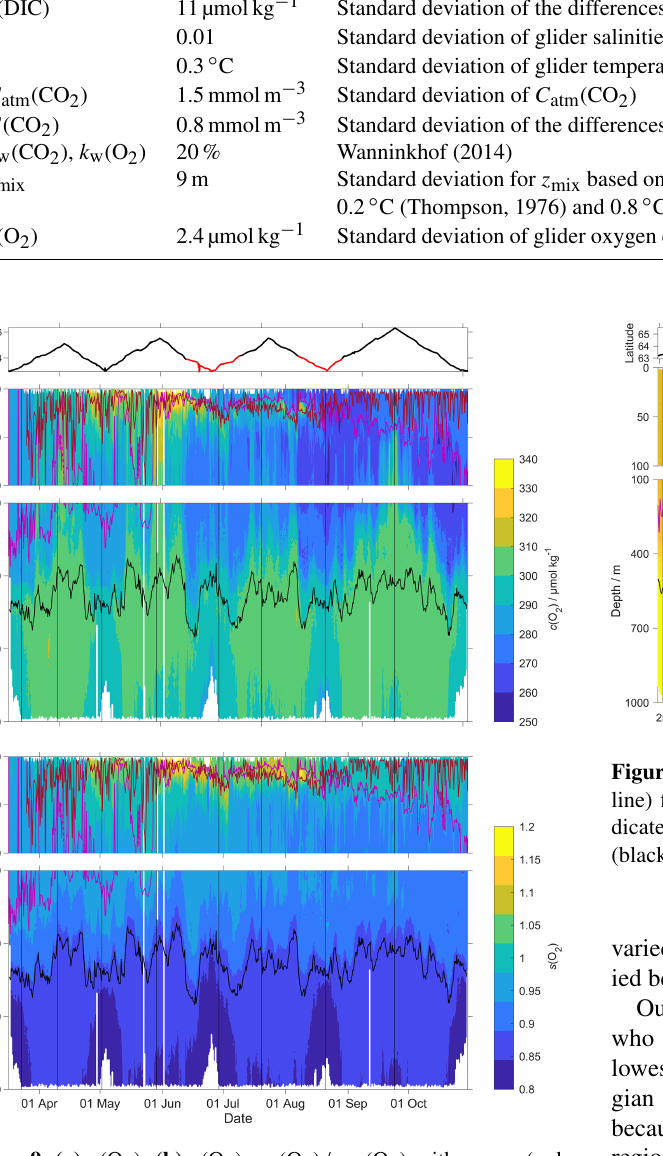
Figure 9. (a) c (O 2 ); (b) s (O 2 ) = c( O 2 )/c sat ( O 2 ) with z DCM (red line), z mix (pink line) five-point median z mix (dotted pink line). The black line indicates σ 0 = 1028kgm − 3 . The top panel indicates glider latitude (black: NwAC; red: NCC).